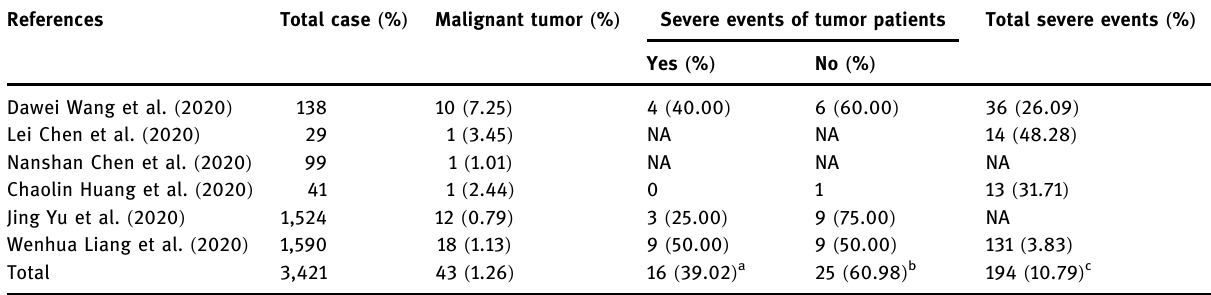
Table 1: Number and severity of malignant tumor patients infected with SARS - CoV - 2